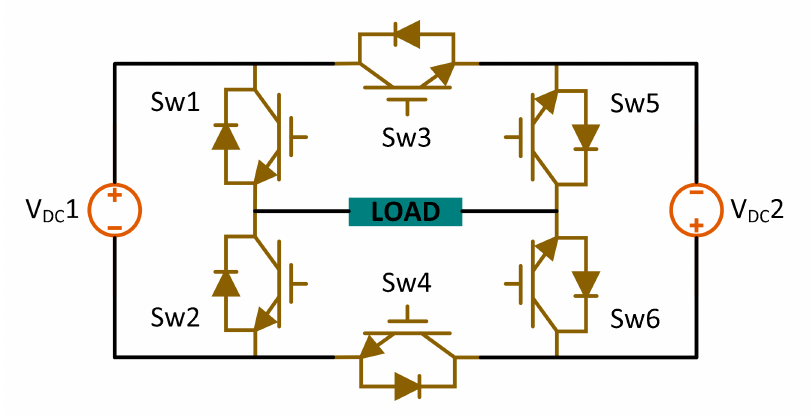
Figure 25. Topology of Babaei multilevel